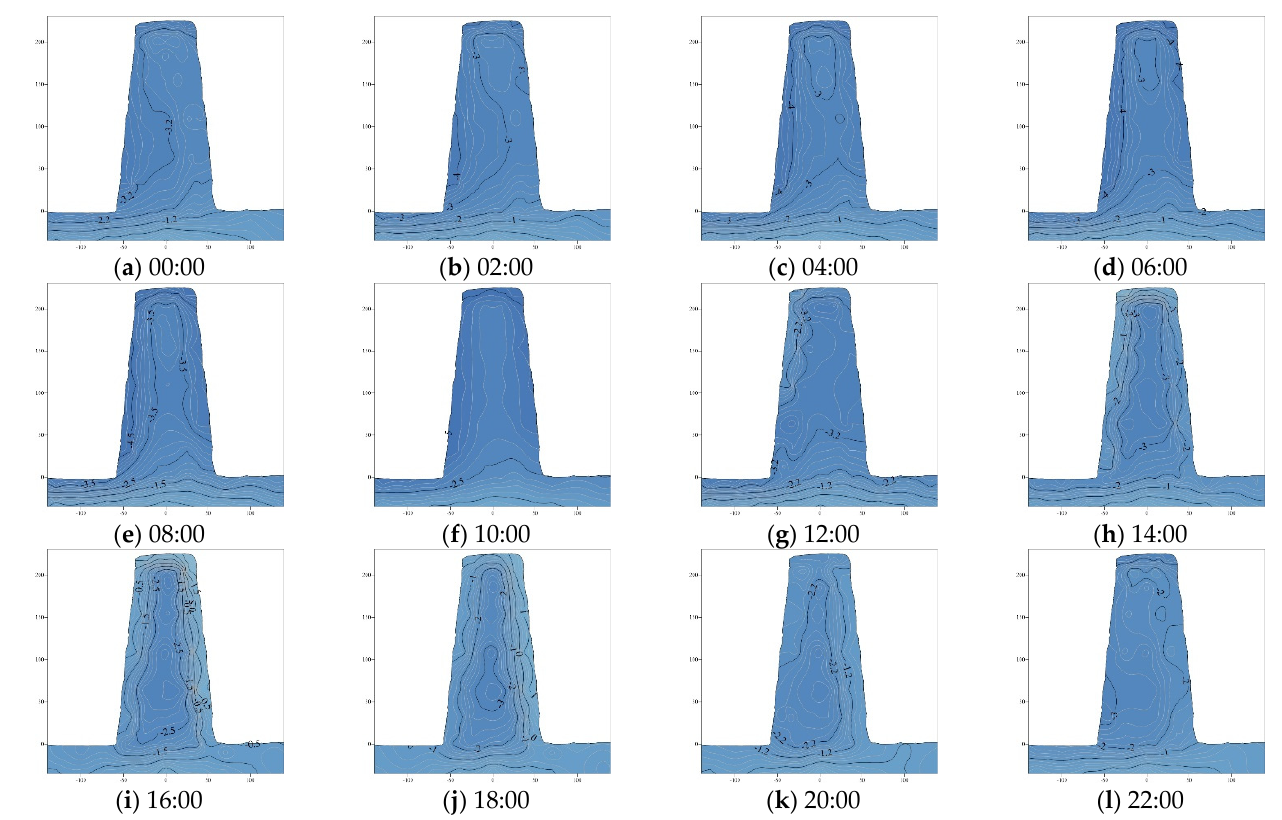
Figure 17. Temperature variations in the test wall on 22 December.